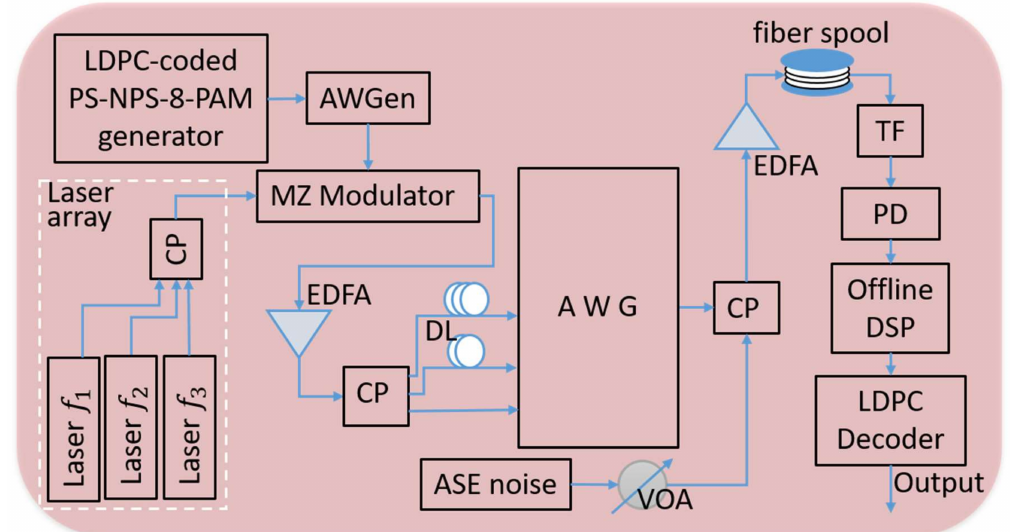
Figure 6. Experimental data center setup. CP: coupler, DL: delay line.